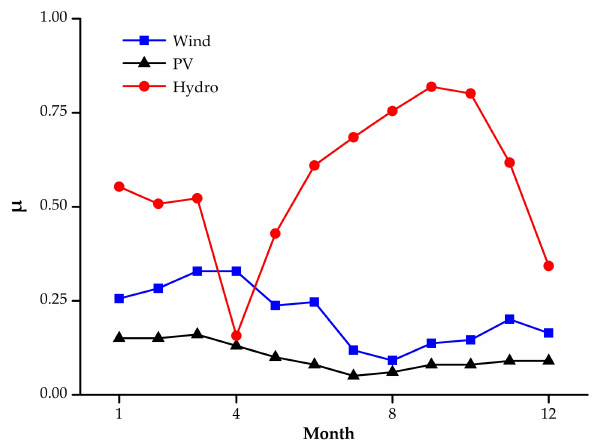
Figure 3. Wind power, photovoltaic power, and hydropower output process in 2016.